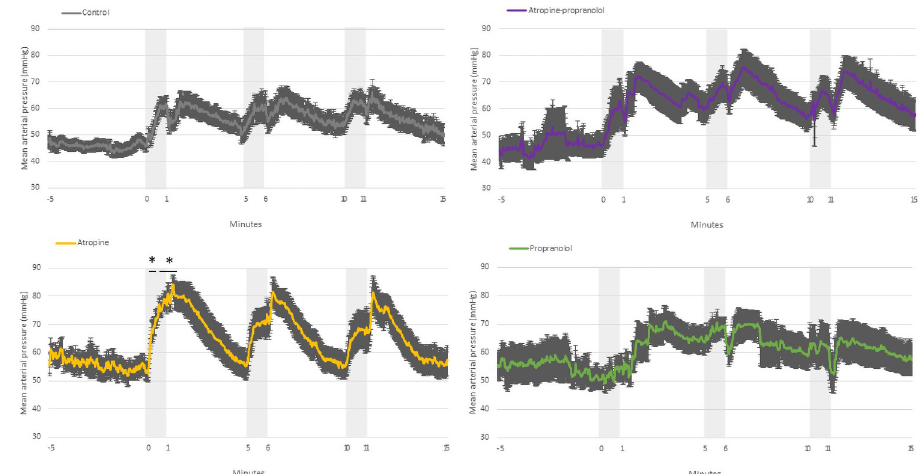
Fig 4. Change in fetal heart rate. Change in fetal heart rate in control, atropine, propranolol and atropine- propranolol protocols in fetuses exposed to three applications of 1-minute umbilical cord occlusion (grey zone) every 5 minutes. Data are expressed as mean ± standard error. � p < 0.05 vs. control. Resolution of each datapoint: 1